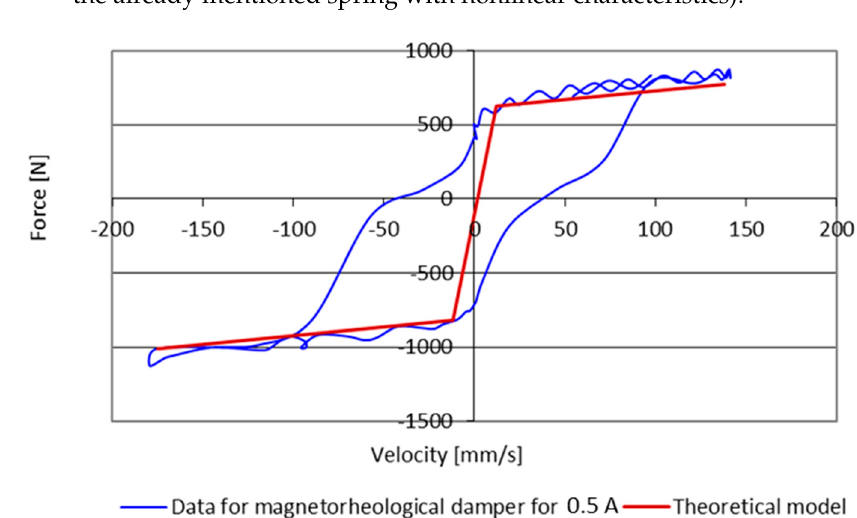
Figure 4. MR damper characteristics and theoretical